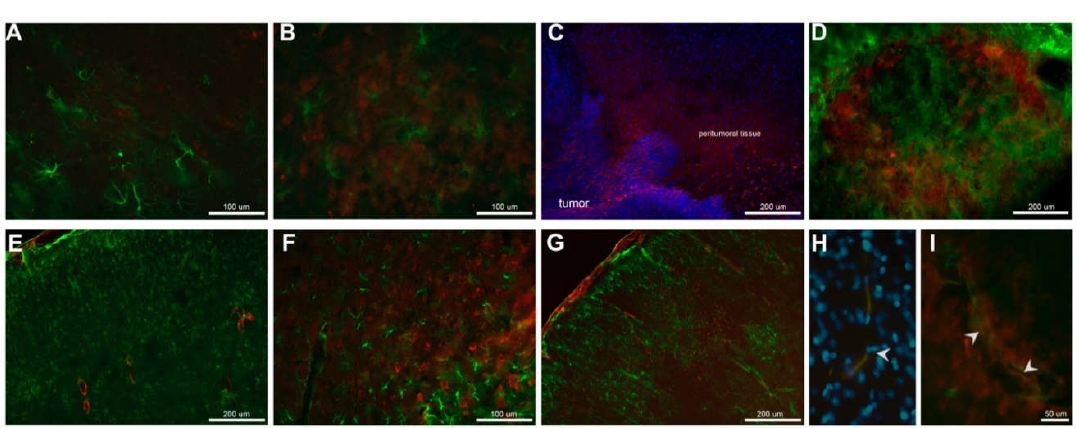
Table 1. Characteristics of the pediatric glioma samples.